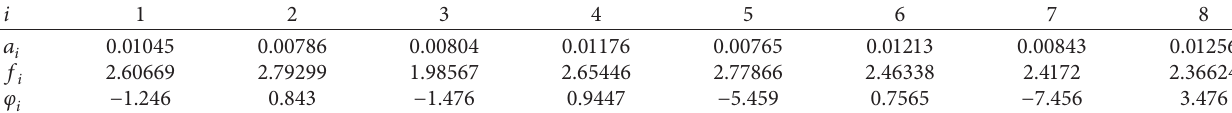
Table 4: Values of 24 fitting parameters in equation (1) in 60 ∼ 80s.